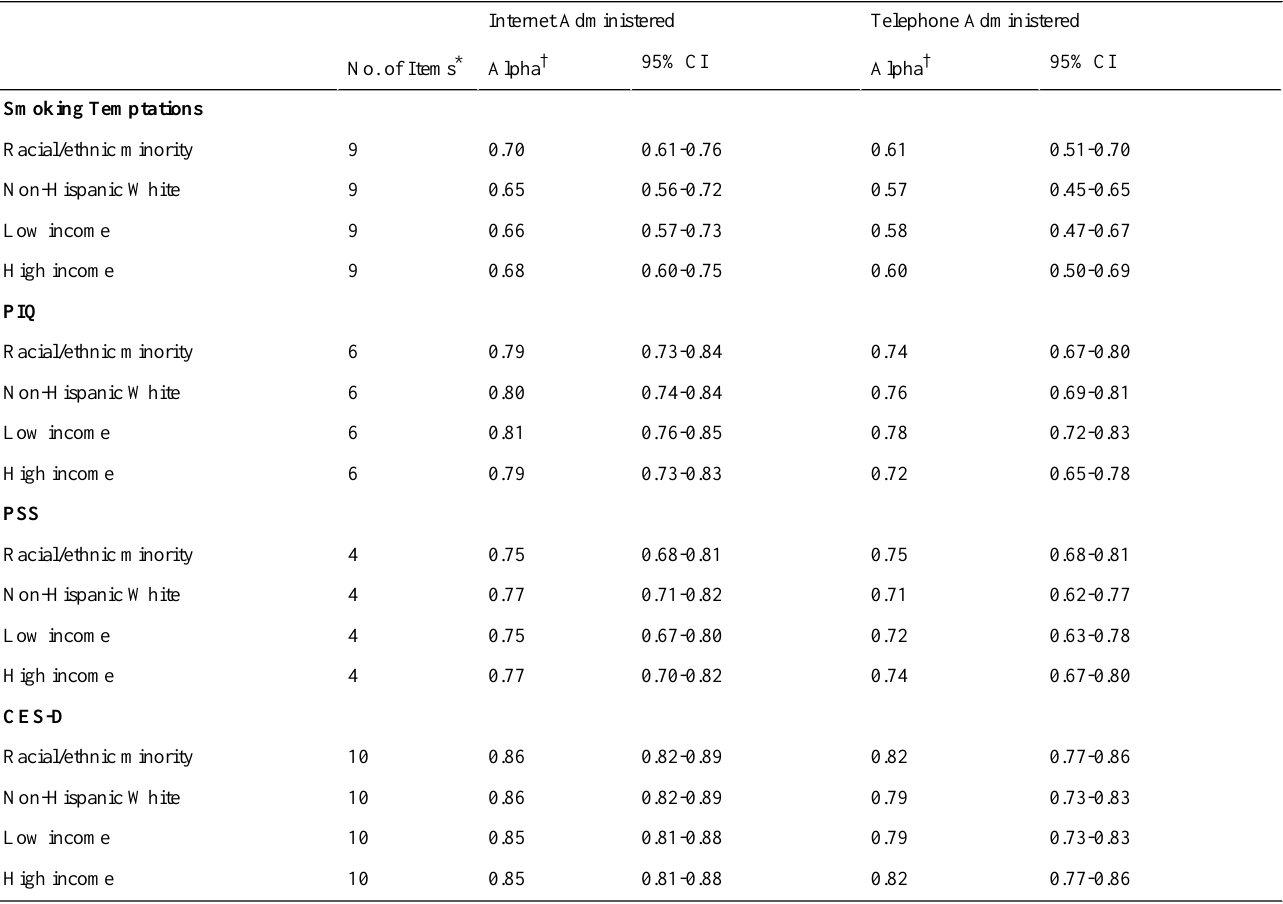
Table 4. Internal consistency of measurement scales: Internet–telephone comparisons stratified by race/ethnicity and income